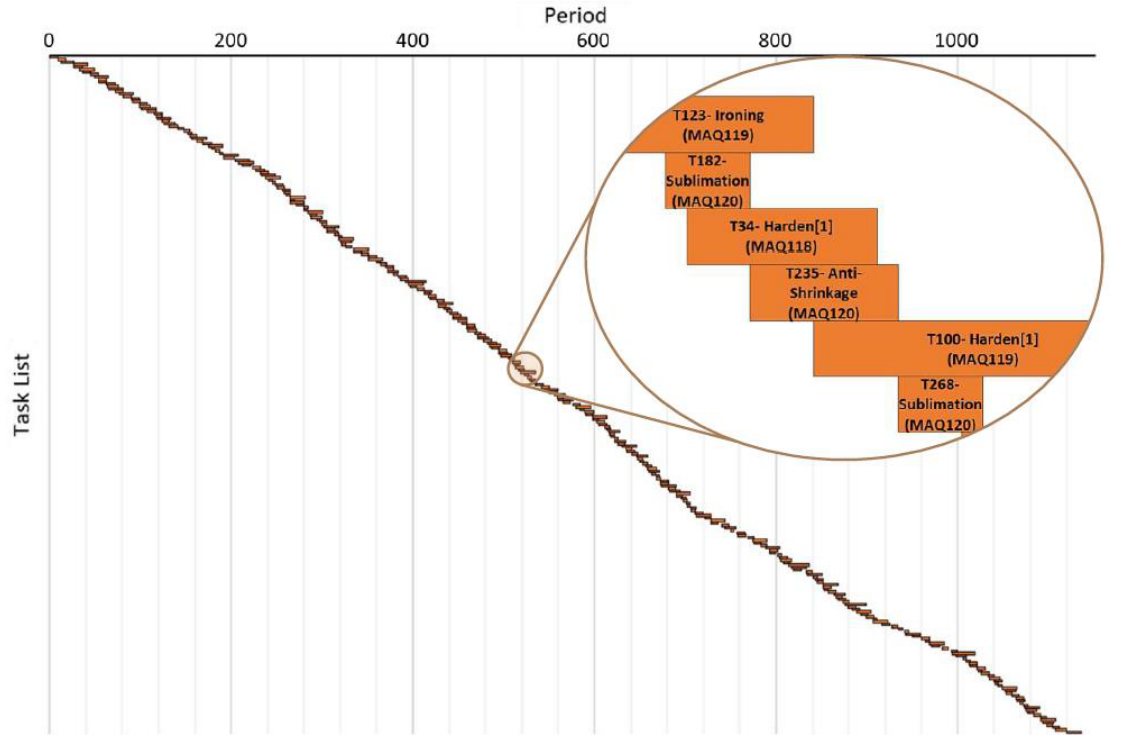
Figure 7. Gantt diagram of the scheduled plan.